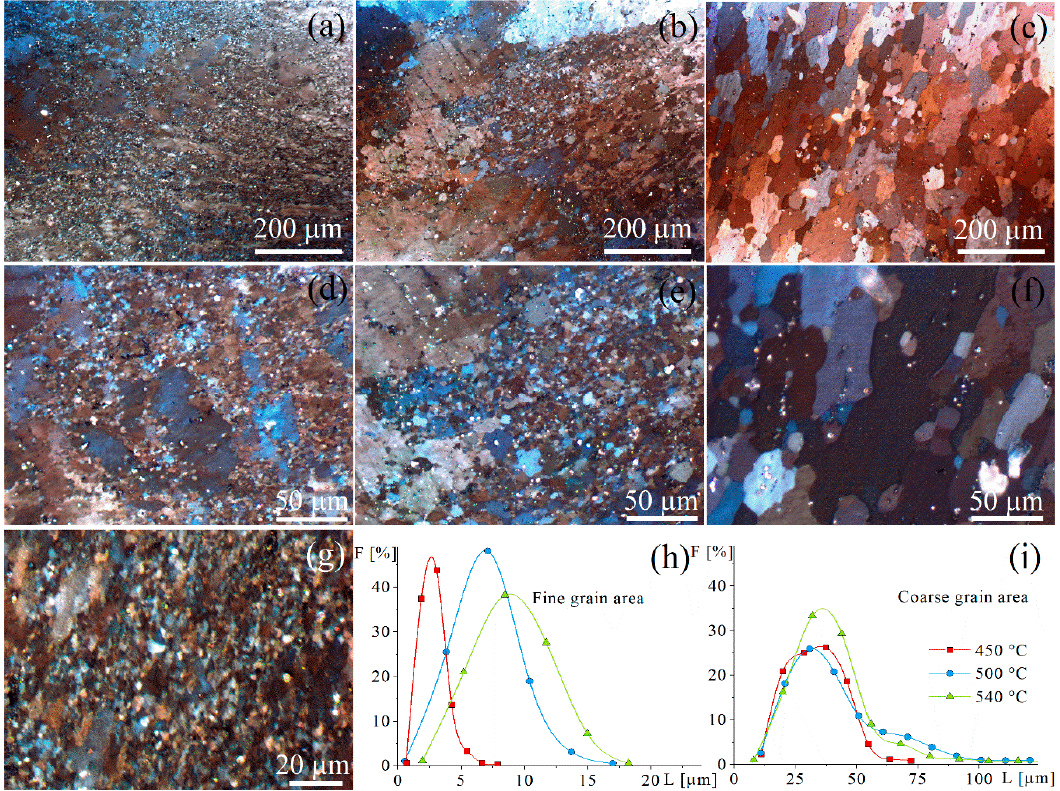
Figure 5. The grain structure in the center part of the sample after isothermal multidirectional forging at 350 ◦ C with a cumulative strain of 6.3 and subsequent annealing at ( a , d , g ) 450, ( b , e ) 500 and ( c , f ) 540 ◦ C for 30 min; ( h ) and ( i ) the grain size distribution in fine grain and coarse grain